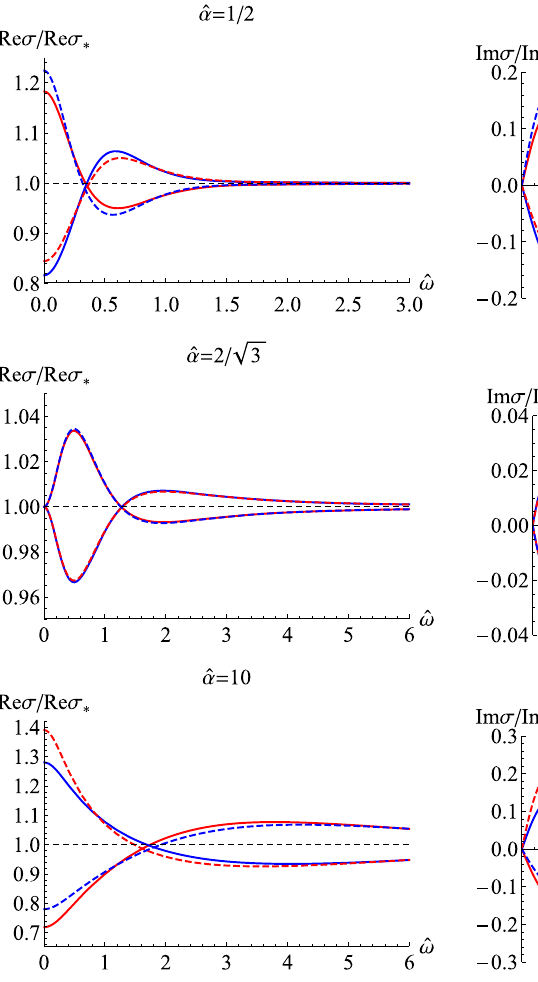
Fig. 11 The real part (left plot) and the imaginary part (right plot) of the optical conductivity as the function of ˆ ω for various values of γ and ˆ α . The solid curves are the conductivity of the original EM theory (3), which have been shown previously in Fig. 1 (red for γ = 1 / 12 and blue